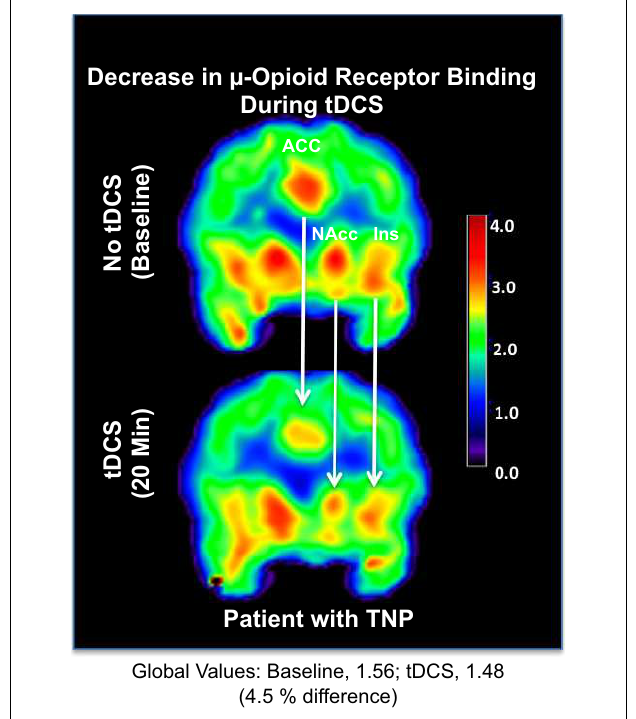
FIGURE 1 | Decrease in µ -opioid receptor binding associated with transcranial direct current stimulation. Upper panel: µ OR BP ND during the baseline PET. Lower panel: µ OR BP ND during active tDCS. ACC, anterior cingulate cortex; NAc, nucleus accumbens; Ins,